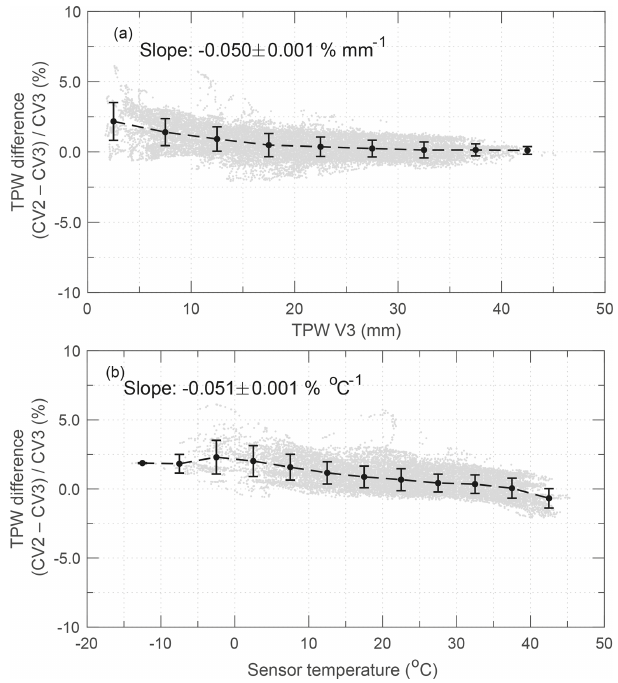
Figure 10. Dependence plot of the relative difference of the TPW from V2 and V3 AERONET algorithms from (a) the total amount of TPW and from (b) the temperature of the censor. The black dots show the average difference in bins of 5mm and 5 ◦ C, and the error bar represents the standard deviation of the mean. The linear fit is based on all measurements.